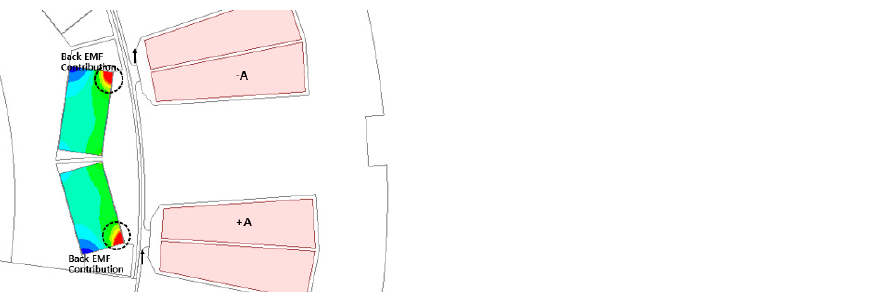
Figure 8. Contribution of Back EMF in Permanent Magnets Calculated Using Finite Element Method.